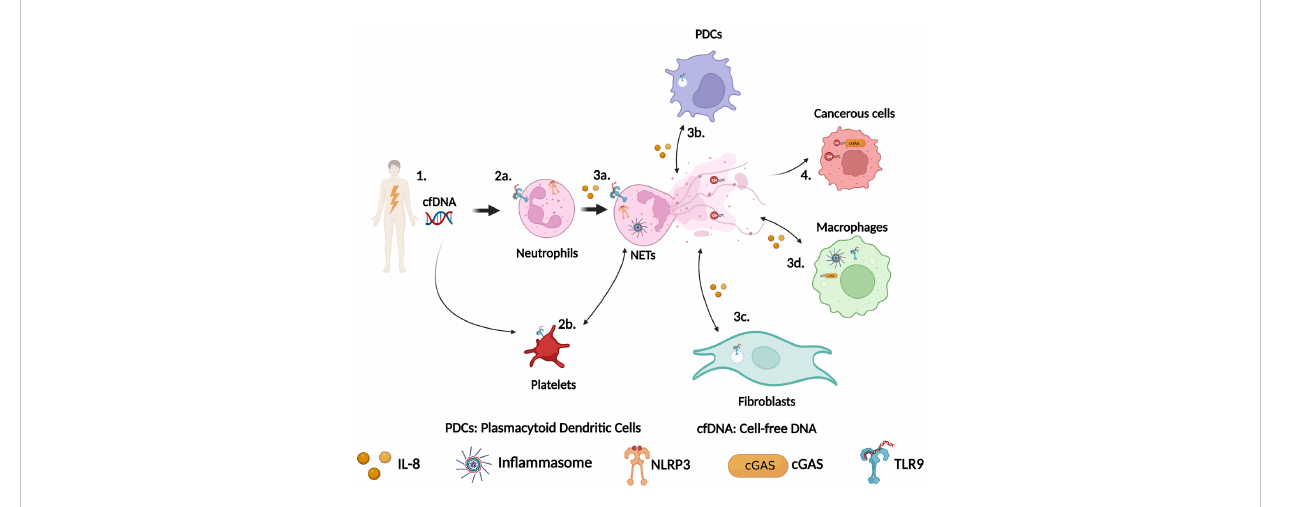
FIGURE 1 Schematic representation of the role of DNA sensors in NETs formation during sterile in fl ammation. (1) Tissue damage leads to cell-free DNA (cfDNA) release in the circulation. This cfDNA can originate from nuclei and mitochondria. (2a) Neutrophils detect cfDNA via their surface or intracellular TLR9 and/or via NLRP3. (2b) Platelets also detect cfDNA via surface TLR9 and activate neutrophils to produce NETs, which in turn drive platelets activation. (3a) Activation of TLR9 or NLRP3 leads to NETs formation. (3b) DNA from NETs is detected by TLR9 in plasmacytoid dendritic cells (PDCs) leading to cytokines production including IL-8, which trigger more neutrophils recruitment. (3c) Similarly, DNA from NETs can also be detected by TLR9 in fi broblasts driving their activation resulting in fi brosis. (3d) DNA from NETs can be phagocytosed by macrophages and sensed by cGAS or by the AIM2/NLRP3 in fl ammasome to stimulate the production of IFN-I response or the secretion of IL-1 b . (4) Sensing of DNA from NETs by cGAS in cancerous cells modulate cancer cells behaviors. This fi gure has been created using